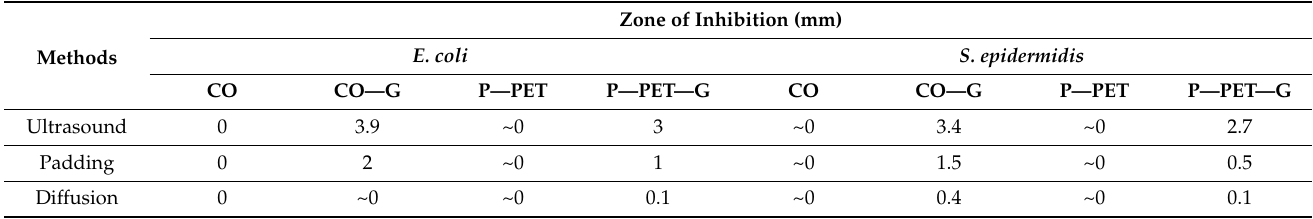
Figure 10. Inhibition zones revealing the antibacterial activity at 37 °C of CO — G and P — PET — G Table 5. Zone of inhibition (mm) of each sample against E. coli and S. epidermidis